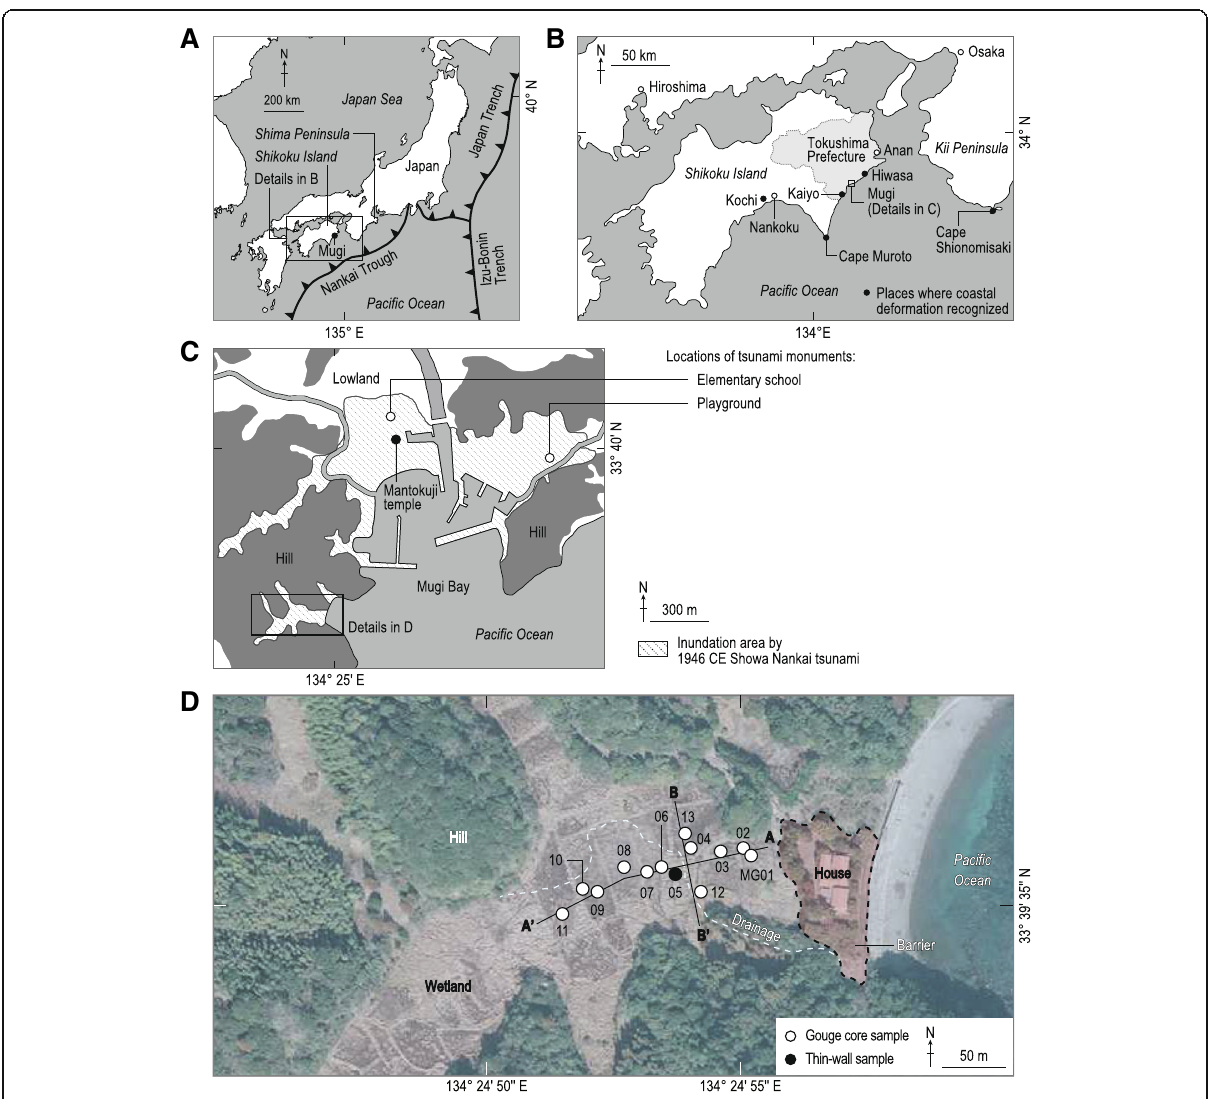
Fig. 1 a Index map of Japan, showing the location and tectonic setting of the study area. b Map of Shikoku Island, showing localities where coastal deformation was recognized from the 1946 CE Showa-Nankai or 1854 CE Ansei-Nankai earthquakes. c Map of Mugi Town, showing the geography, landmarks mentioned in the text, and the area inundated by the 1946 CE Showa-Nankai tsunami (stippling). d Aerial photograph of the study site, showing the geography and sediment sampling points and transects (photograph CSI20121-C10-13 by the Geospatial Authority of Japan, taken 21 February